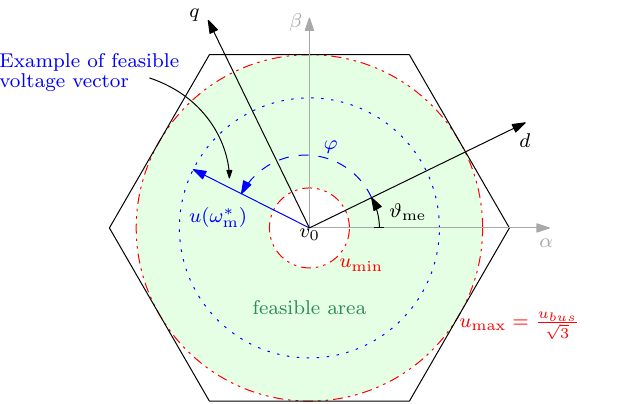
Figure 1. Voltage plane area. The green area represents the feasible voltage vector region limited by the red-dot-dashed